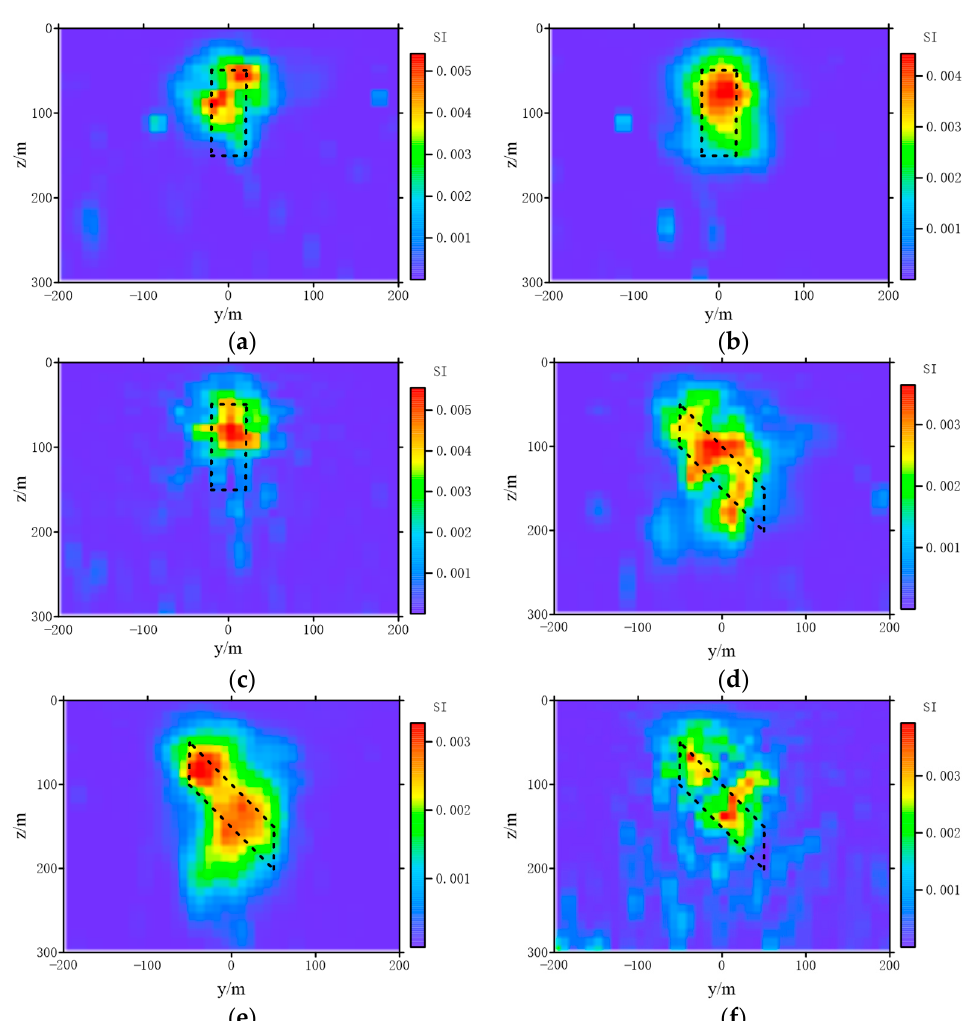
Figure 6. The smooth and non-smooth inversion results of Model 1 and Model 2. ( a ) The smooth inversion of Model 1 ( (cid:1868) (cid:3033) = 1 ), ( b ) the smooth inversion of Model 1 ( (cid:1868) (cid:3033) = 2 ), ( c ) the non-smooth inversion of Model 1, ( d ) the smooth inversion of Model 2 ( (cid:1868) (cid:3033) = 1 ), ( e ) the smooth inversion of Model 2 ( (cid:1868) (cid:3033) = 2 ), ( f ) the non-smooth inversion of Model 2. 3.2. The Influence of P in Model Objective Function on Inversion Results Figure 7 is the cross-section through the x-axis composed of two 2-D magnetic dyke models. Figure 7. The cross-section through the x-axis of the model. 0